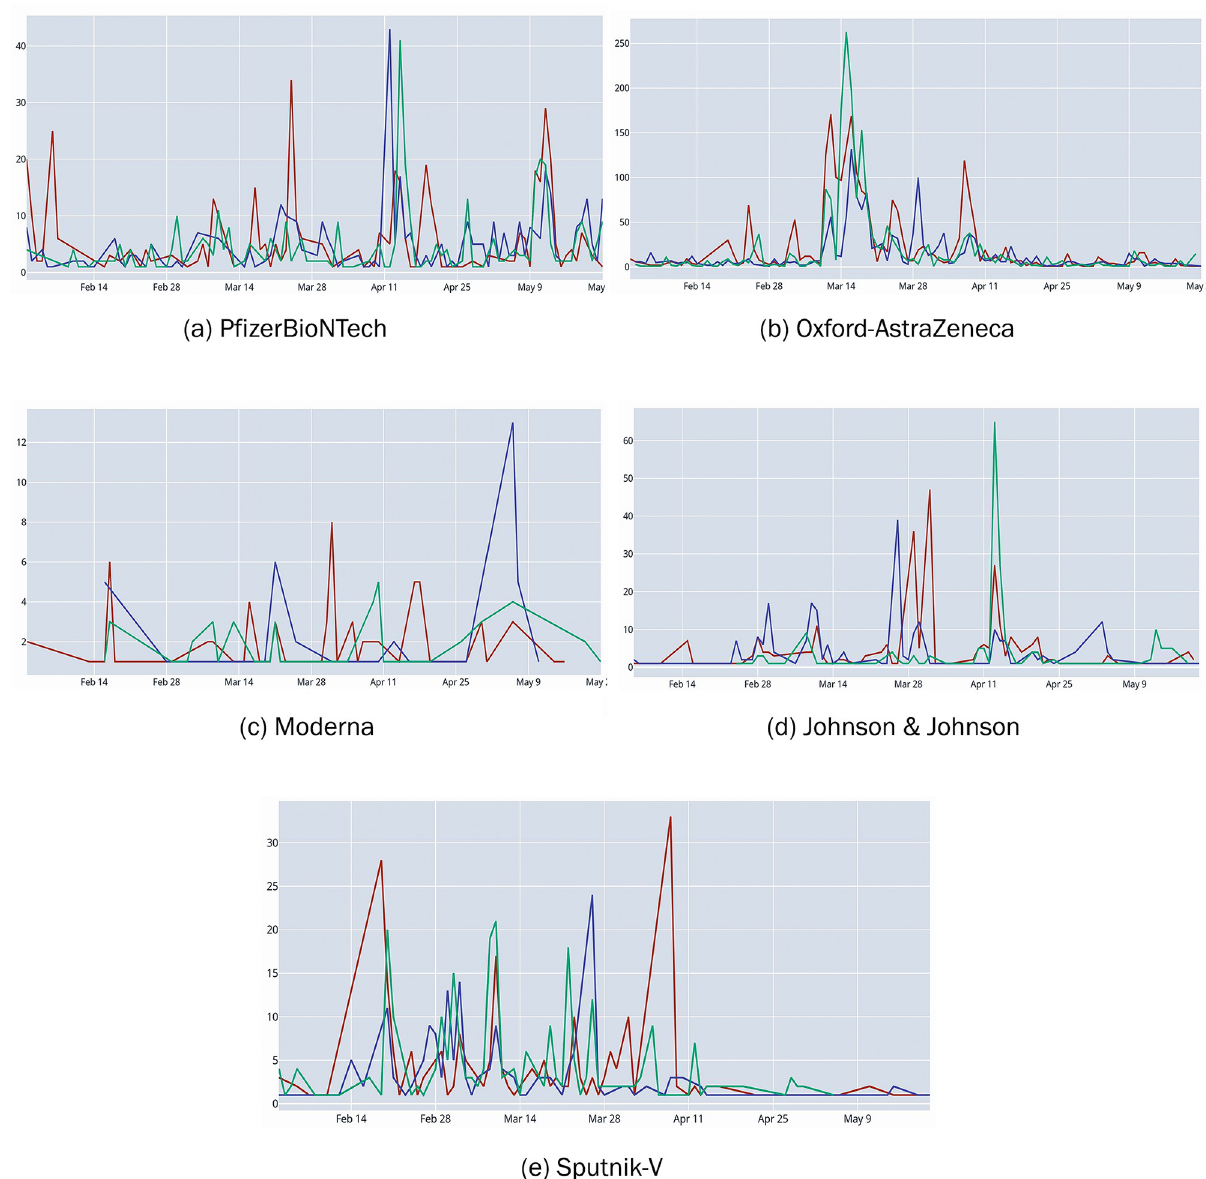
Fig 5. Timeline showing sentiments of tweets about different vaccine brands. Each graph reports the daily number of tweets for the observed period. Different line colours indicate tweet polarity: green (positive), red (negative) and blue (neutral).